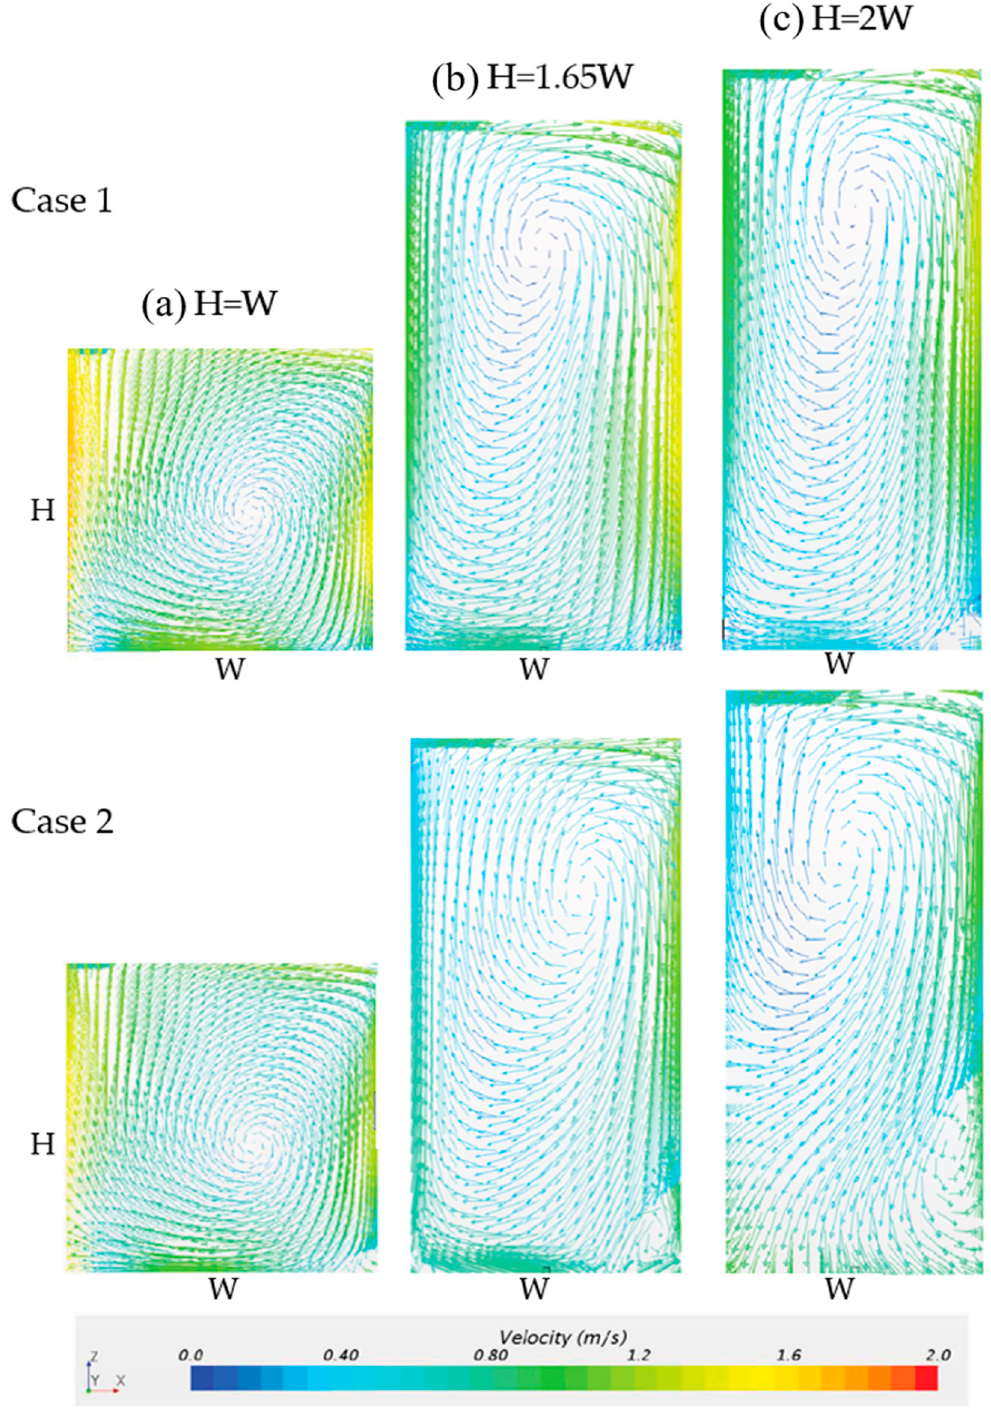
Figure 11. Velocity vectors obtained in the two cases within a street canyon with aspect ratio 1 ( a ), 1.65 ( b ) and 2 ( c ). Case 1 ( top ) and Case 2 ( bottom ).